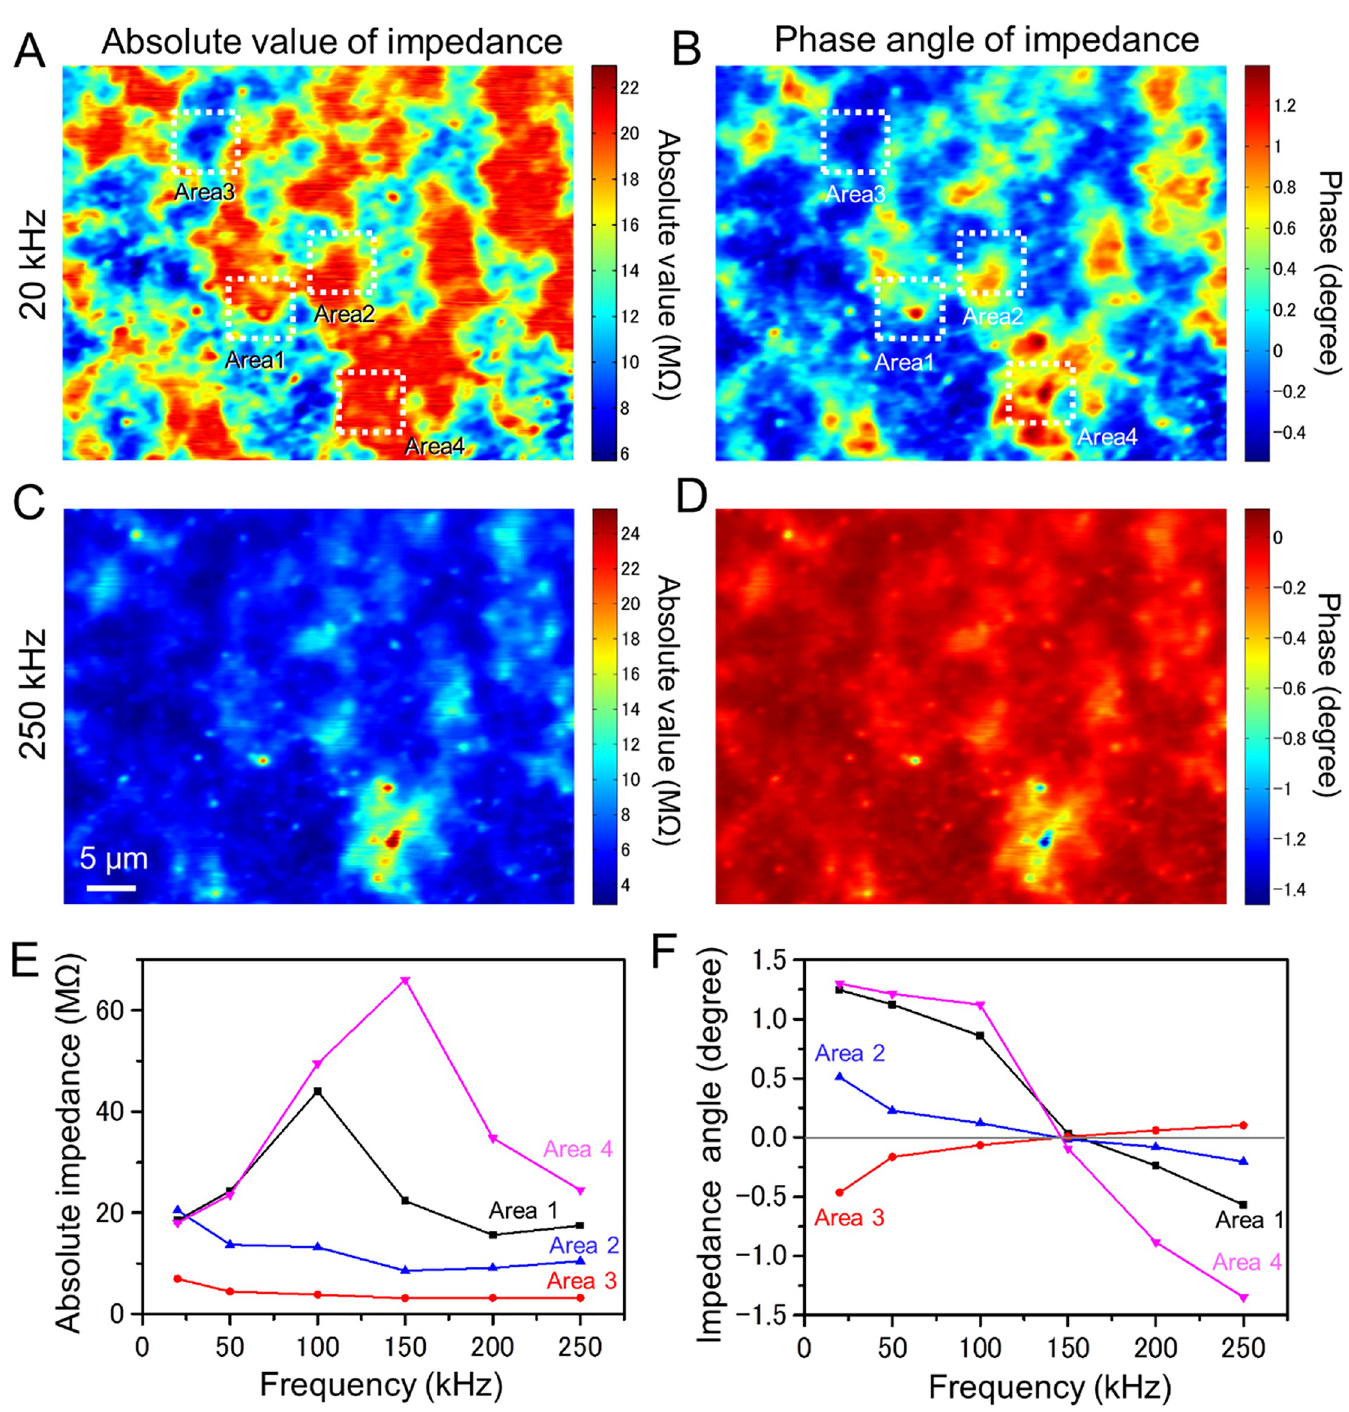
Fig 6. The impedance amplitude and phase colour maps of the whole milk sample. (A) A colour map of absolute impedance of the whole milk sample (EB accelerating voltage 7 kV, EB current 400 pA, input frequency 20 kHz, magnification 1,000 × ). The impedance range in map is 6–22 M O . (B) Simultaneously obtained an impedance phase map. (C) Amplitude map of the same area scanned in (A) with a 250-kHz input signal (other conditions unchanged). The impedance range of its map is expanding to 4–25 M O . (D) Simultaneously obtained an impedance phase map. (E) The absolute impedance versus input frequency of the white and black particles in the centres of Areas 1–4 in (A). Areas 1 and 4 shows sharp peak at 100 kHz and 150 kHz input frequency. By contrast, the amplitude of Area-2 shows almost flatten in whole frequency. (F) A frequency characteristic of phase at the white and black particles in the centres of Areas 1–4. Scale bar, 5 μ m in (C).